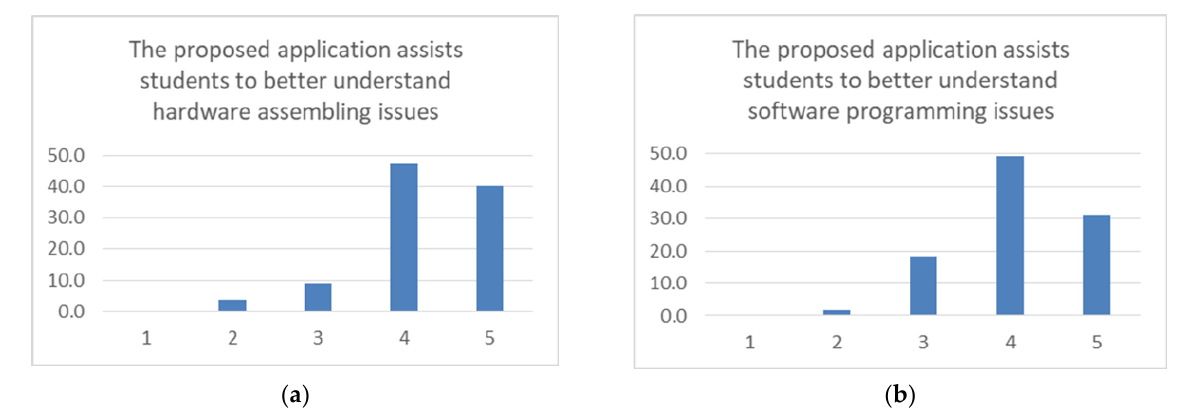
Figure 14. Opinions about the contribution of the proposed activity to understand: ( a ) hardware assembling topics; ( b ) software programming topics.